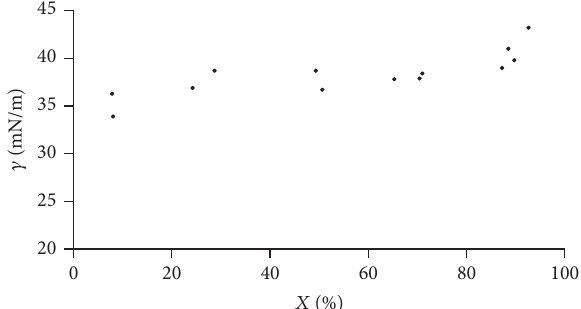
Figure 4: Evolution of surface tension ( 𝛾 ) with global conversion ( X ) in the copolymerization of MMA/MAA (2/1,